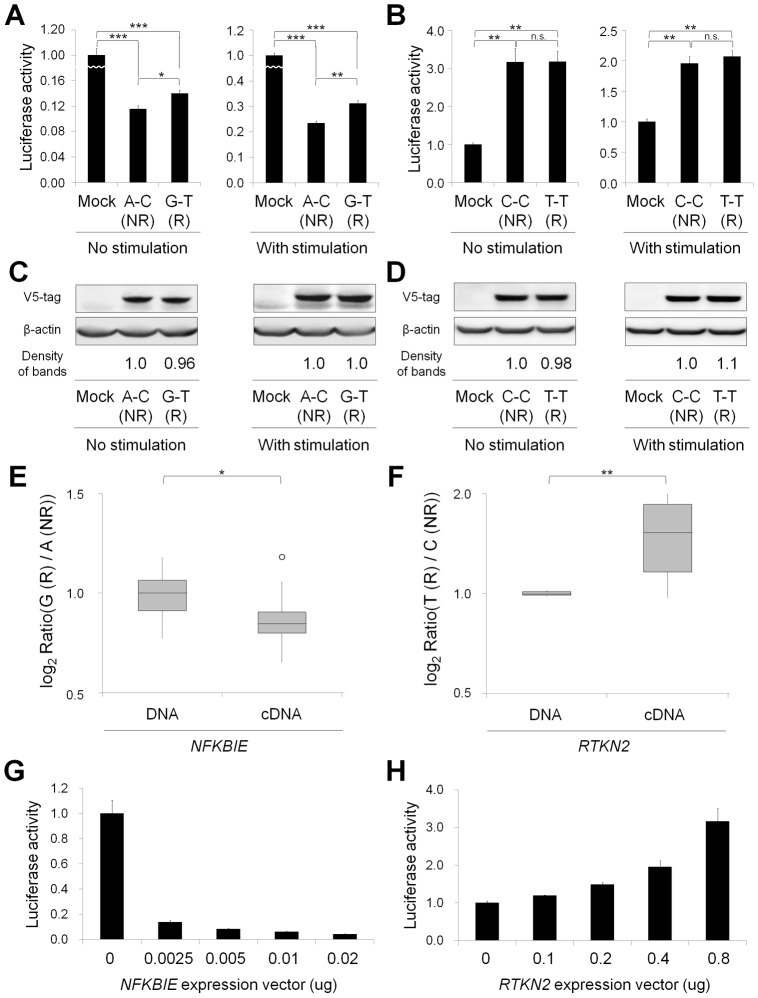
Functional evaluation of nsSNPs and allelic imbalance of expression in NFKBIE and RTKN2.(A, B) Effects of nsSNPs in NFKBIE (A) and RTKN2 (B) on NF-κB activity by luciferase assays. Two haplotype constructs (A-C (rs2233434-rs2233433; non-risk (NR)) and G-T (risk (R)) for NFKBIE and C-C (rs3125734-rs61850830; NR) and T-T (R) for RTKN2) were used. The expression vector of each construct, pGL4.32[luc2P/NF-κB-RE] vector and pRL-TK vector were transfected into HEK293A cells. Data represent the mean ± s.d. Each experiment was performed in sextuplicate, and experiments were independently repeated three times. *P<0.05, **P<1.0×10−5, and ***P<1.0×10−10 by Student's t-test. n.s.: not significant. (C, D) Protein expression levels of each haplotype construct. Anti-V5 tag antibody was used in the Western blotting analysis to detect the expression of exogenous IκBε (C) and RTKN2 (D). Beta-actin expression was used as an internal control. The densities of the bands were quantified and normalized to that of the risk allele. (E, F) Allelic imbalance of expression in NFKBIE (E) and RTKN2 (F). ASTQ was performed using samples from individuals heterozygous for rs2233434 (G/A) in NFKBIE and rs3125734 (T/C) in RTKN2. Genomic DNAs and cDNAs were extracted from PBMCs (n = 14 for NFKBIE and n = 6 for RTKN2). The y-axis shows the log2 ratio of the transcript amounts in target SNPs (risk allele/non-risk allele). The top bar of the box-plot represents the maximum value and the lower bar represents the minimum value. The top of box is the third quartile, the bottom of box is the first quartile, and the middle bar is the median value. The circle is an outlier. *P = 0.012, **P = 0.016, by Student's t-test. (G, H) Dose-dependent inhibition of NFKBIE (G) and activation of RTKN2 (H) on NF-κB activity. Various doses of expression vectors carrying the non-risk allele of each gene were transfected into HEK293A cells with pGL4.32 and pRL-TK vectors.